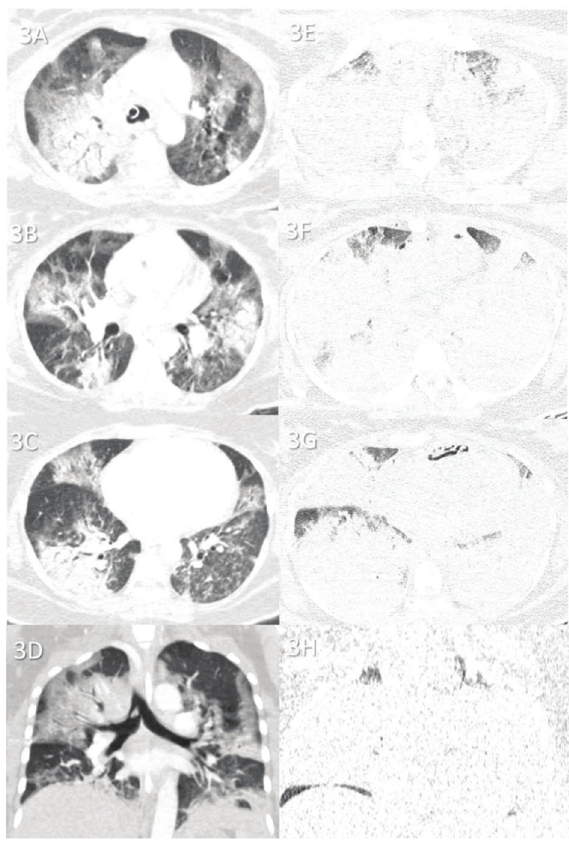
Figure 3 - Case 3: Premortem axial chest computed tomography (CT) of the upper (A), mid (B), and inferior (C) thirds of the lungs obtained 2 days before death showing patchy peripheral and central ground-glass opacities and bilateral but mainly periph- eral consolidations. Postmortem axial chest CT of the upper (E), mid, (F) and inferior (G) thirds of the lungs obtained 17 h 19 min after death showing rapid progression of the disease, with extensive consolidations in both lungs and a few areas of preserved pulmonary parenchyma. Images D and H show pre- and postmortem coronal reformats, respectively.